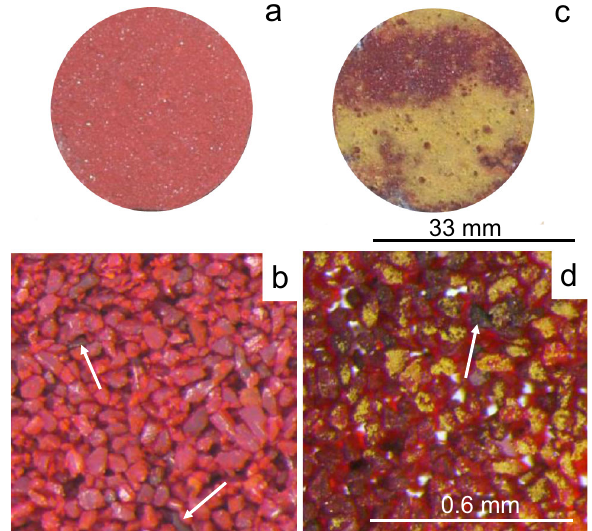
Fig. 2 Chromatic and textural features of cinnabar pigment. a , b Unaltered (control) sample (scale bars as in c , d , respectively) and c , d 2 months after UV aging. Arrows indicate dark-colored grains corresponding to accessory minerals.